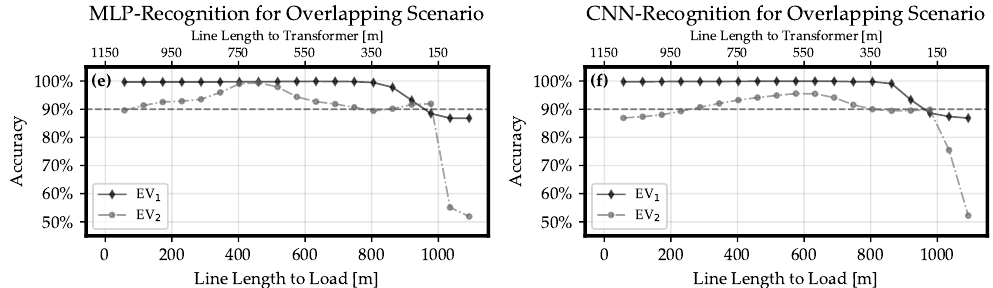
Figure 11. Relation between line length from measurement point to the transformer and to the load bus and the recognition accuracy using the best CNN and the best MLP found during the hyper- parameter optimization. Each panel shows decreasing accuracies with increasing line length achieved by either the MLP or the CNN. The results in ( a – d ) are based on a dataset containing an activation of one electric vehicle (EV), while the other one was inactive. In ( e – f ) an overlapping situation is